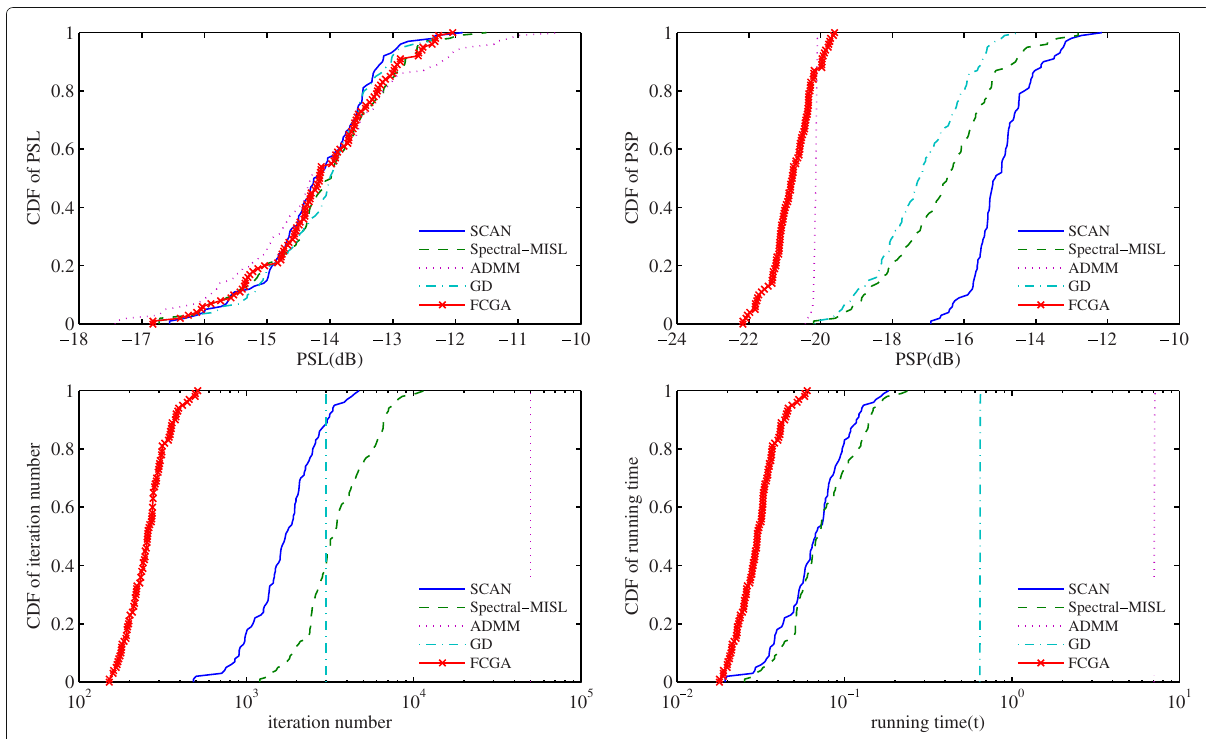
Fig. 10 The cumulative distribution functions of the PSL, PSP, iteration number, and running time